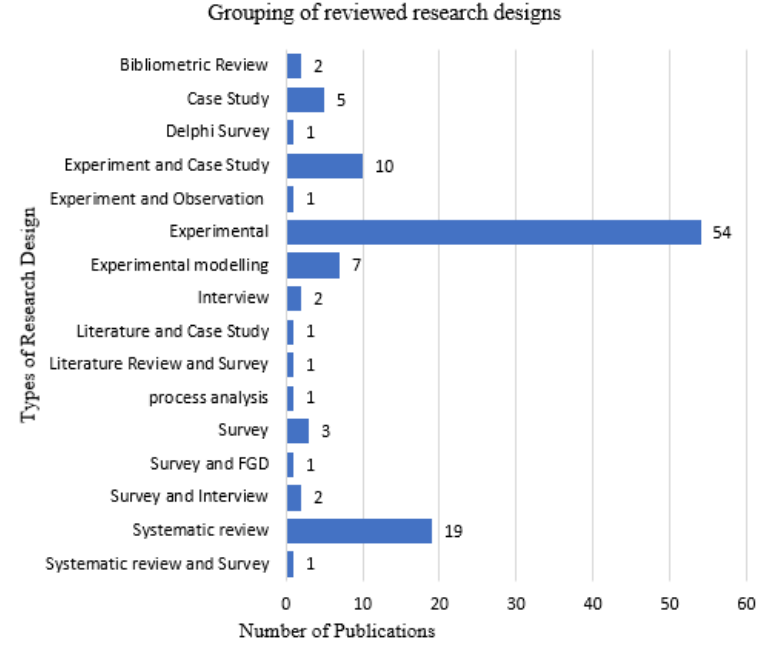
Figure 7. Research designs employed in the construction robotics and human–robot teams litera-